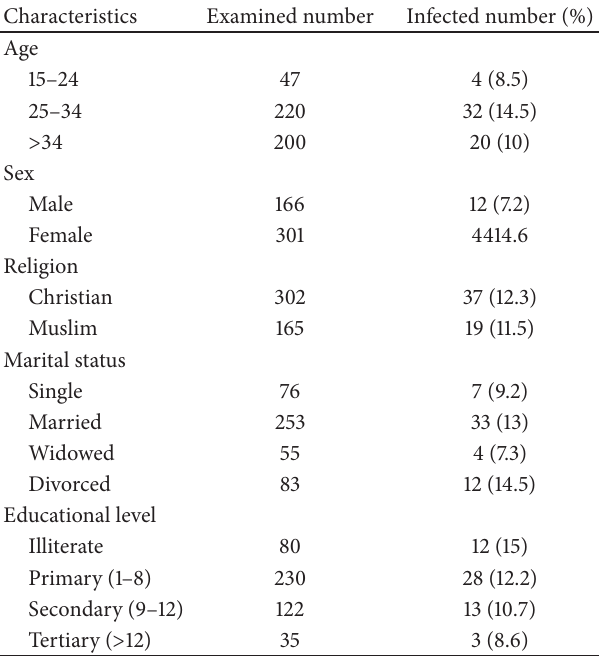
Table 2: Prevalence of UTI by sociodemographic features among seropositive ART user and non-ART user patients, JUSH, Ethiopia, 2012.